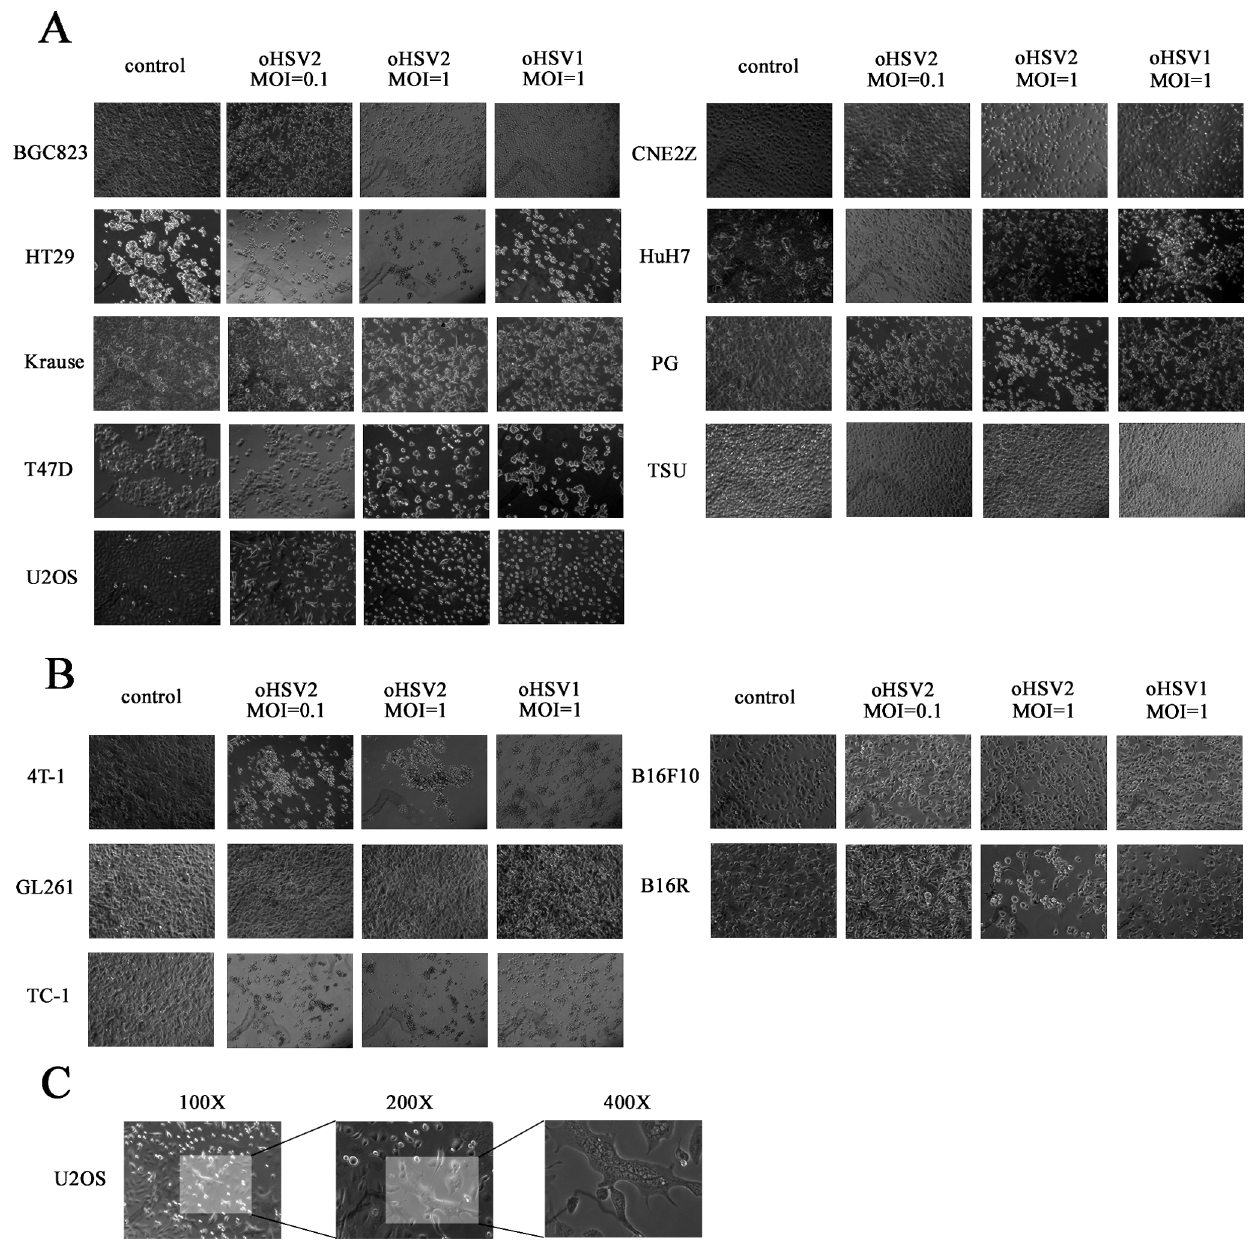
and Treg cells in the spleens of mice after each treatment by flow cytometric analysis. As shown in Fig. 5C, DOX treatment reduced the NK frequency in the spleens (0.20%) compared with the control group (3.75%). In contrast, oHSV2 treatment had a marked effect on NK frequency (13.64%) compared with the control